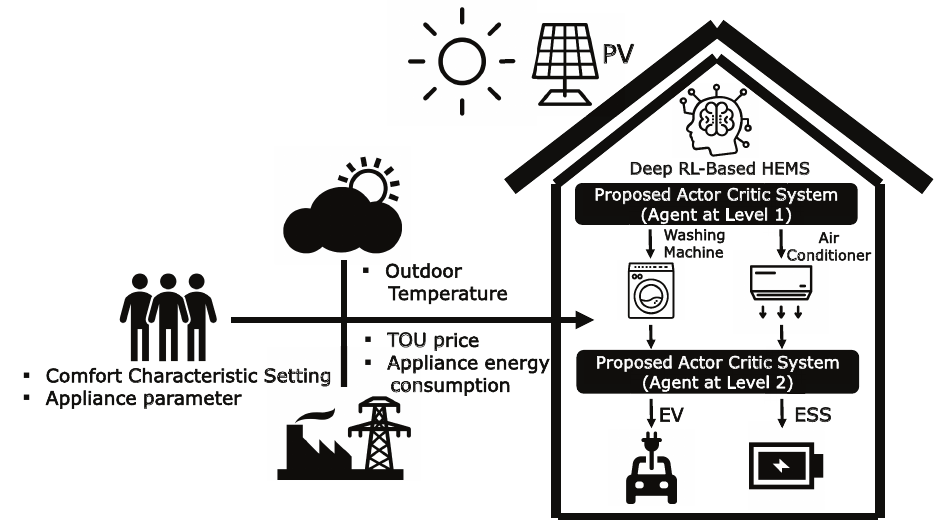
Figure 1. Conceptual architecture of the proposed deep reinforcement learning (DRL)-based home energy management system (HEMS)